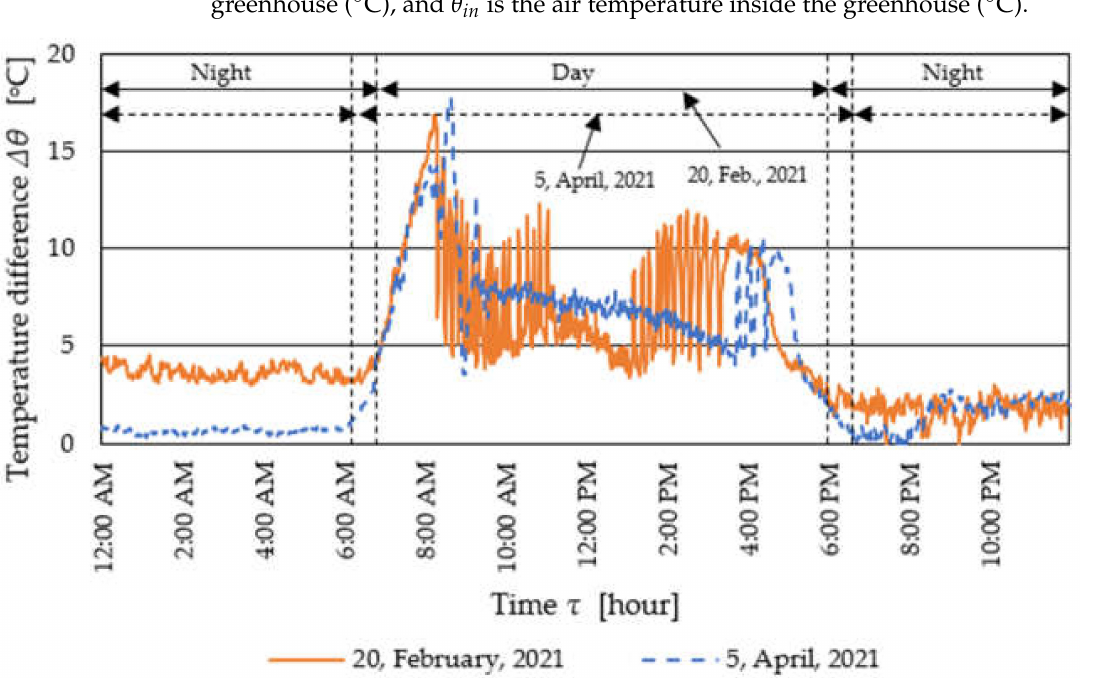
radiation—the peak value of solar radiation was high outside, at 905 W/m 2 , and it was 628 W/m 2 inside the